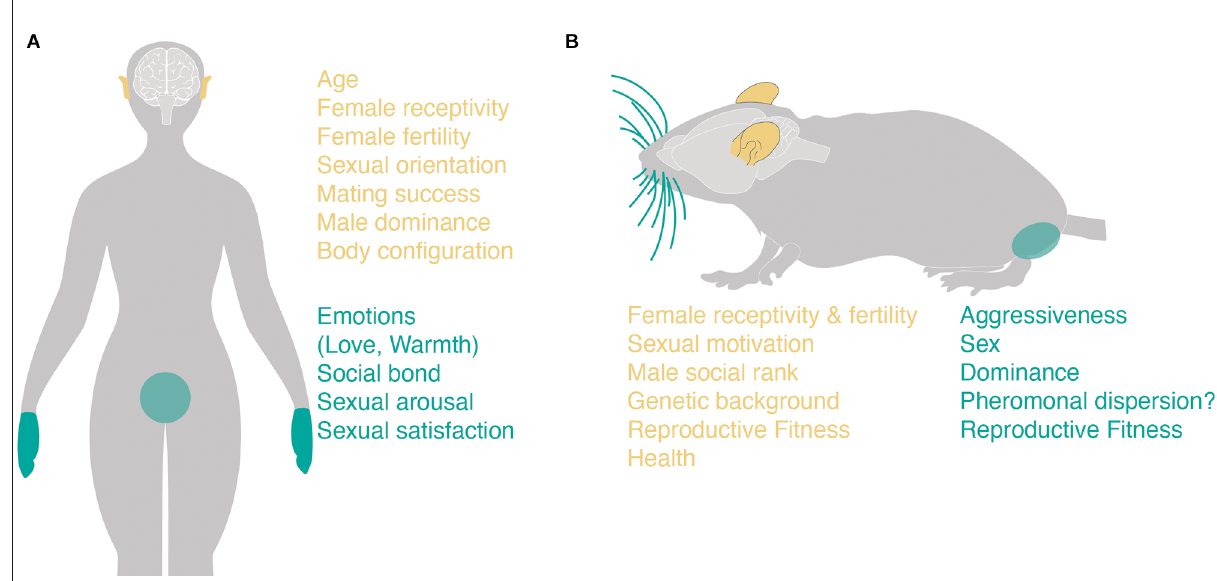
FIGURE2 Potential roles of touch and audition during human and mice/rat mate choice. (A) The parameters that are transmitted via differential voice features in humans (left panel, human ears) are written in yellow (right panel) whereas those that can transmit differential valence of socio-sexual touch (right panel, hands, and genitals) are highlighted in turquoise. (B) Same as (A) but for mice (upper panel). The different social cues or internal states that can be transmitted via ultrasonic vocalizations in mice are highlighted in yellow (lower left panel) whereas those that may be communicated via socio-sexual are written in turquoise (lower right